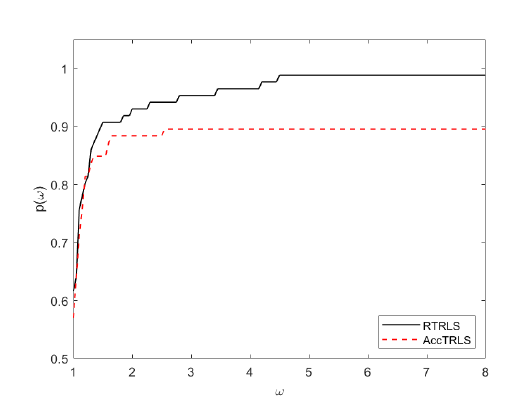
Figure 2. Number of objective func- tion evaluations performance profiles